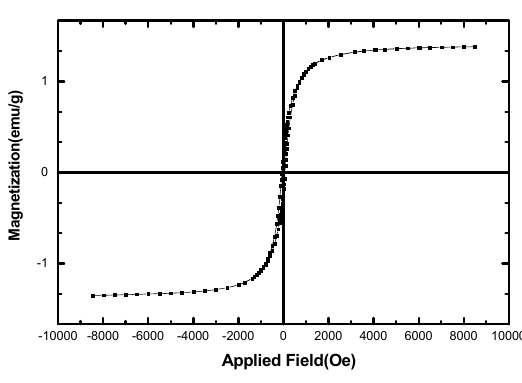
Fig. 7. Room temperature hysteresis loop of magnetic starch-CuFe O (5%) nanocomposite 2 4